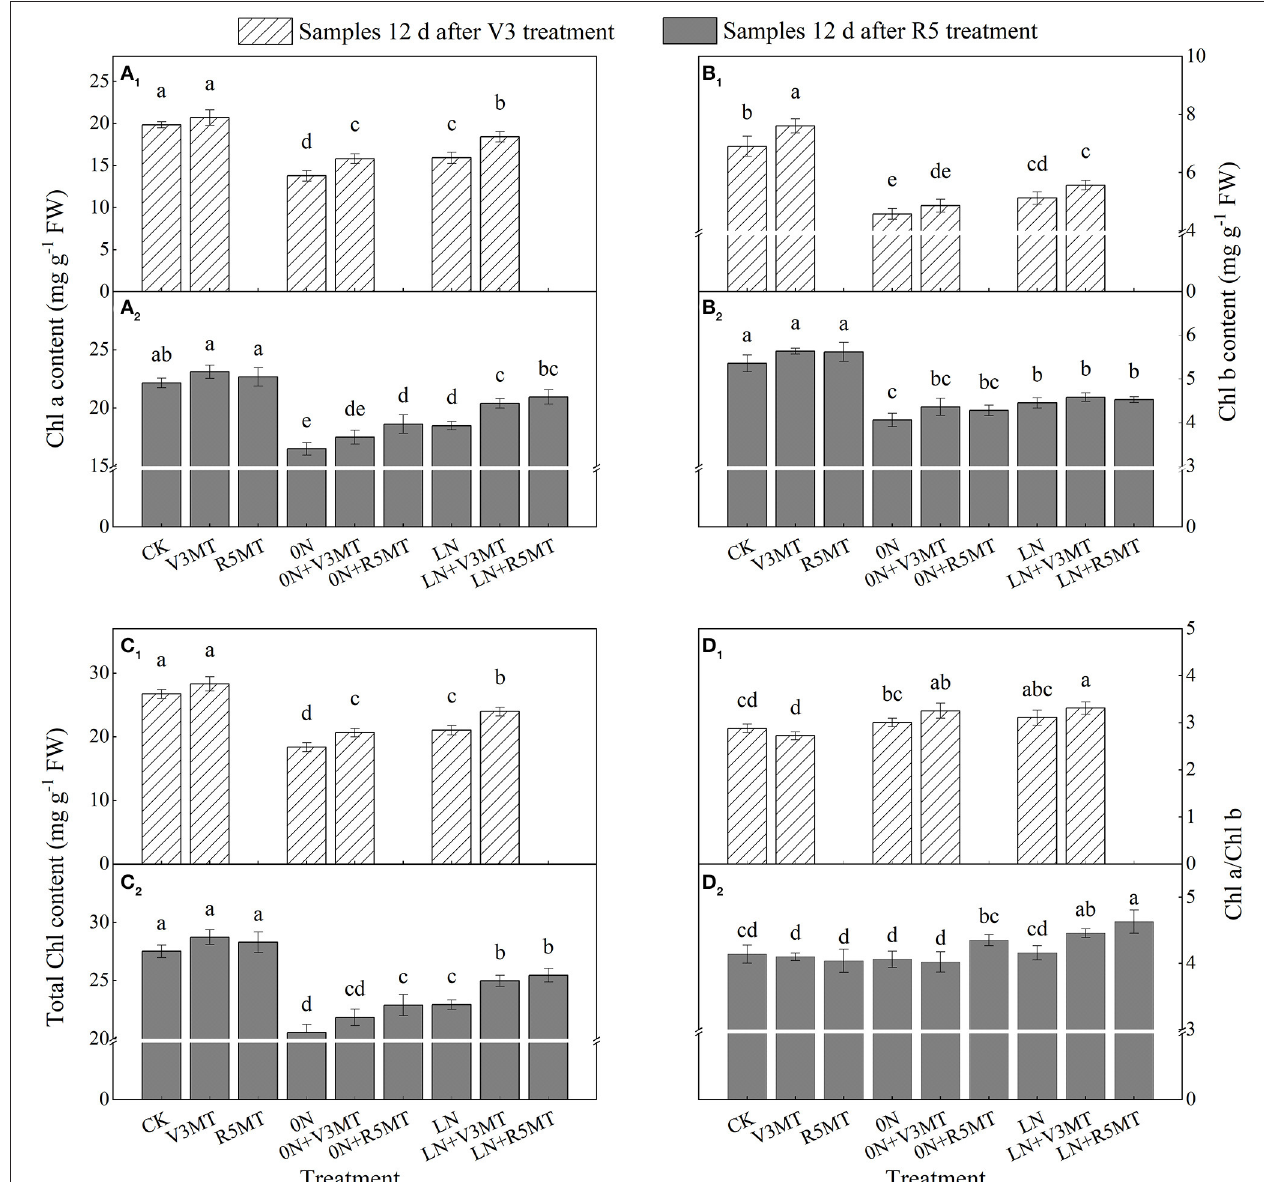
FIGURE 9 | The effect of exogenous melatonin (V3 and R5) on the content of Chl a (A) , Chl b (B) , total Chl (C) , and the ratio of Chl a/Chl b (D) in plant leaves under three N levels. The abbreviated meaning of each treatment is the same as in Figure 3 . The values were presented as mean ± SE ( n = 3). Different letters in one measuring group indicate statistically significant differences when P ≤